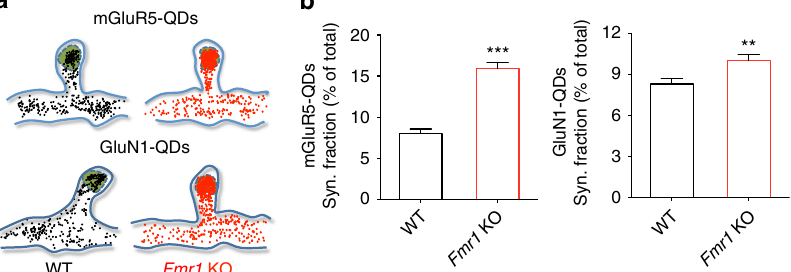
Fig. 3 mGluR5 and GluN1 are more con fi ned within the synaptic compartment in Fmr1 KO neurons. ( a ) Representative surface distribution of mGluR5-QD (upper panel) and GluN1-QD (lower panel) in a 500-frame stack (each dot represents the detection of a single receptor during 50-ms acquisition time), revealing the synaptic site as a trapping zone (green). ( b ) Relative fractions of synaptic mGluR5-QD (left panel) and GluN1-QD (right panel) particles. These values are increased in Fmr1 KO neurons (mGluR5-QD: WT, 8.053 ± 0.504 %, n = 16 dendritic fi elds from 3 cultures; Fmr1 KO, 15.95 ± 0.685 %, n = 14 dendritic fi elds from 3 cultures; ***P < 0.001, t = 9.44, df = 28, unpaired Student ’ s t -test; GluN1-QD: WT, 8.318 ± 0.382 %, n = 63 dendritic fi elds from 6 cultures; Fmr1 KO, 10.02 ± 0.446 %, n = 51 dendritic fi elds from 6 cultures; **P < 0.01, t = 2.91, df = 112, unpaired Student ’ s t -test)